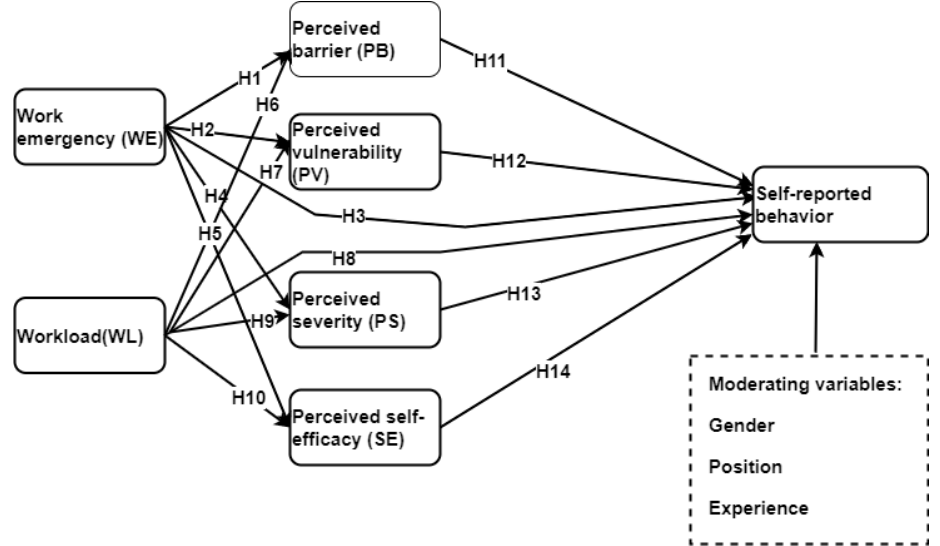
Figure 1. Research model for SMS-based phishing simulation